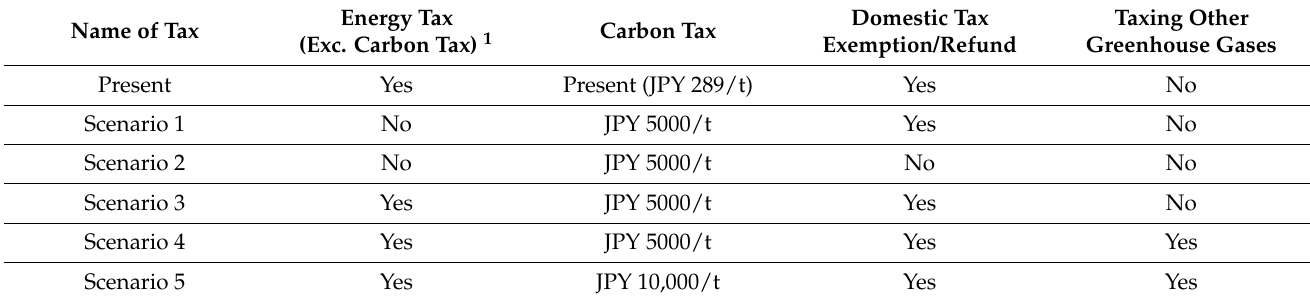
Table 4. Scenarios for estimating the price change of products due to a change in the carbon tax policy. Name of